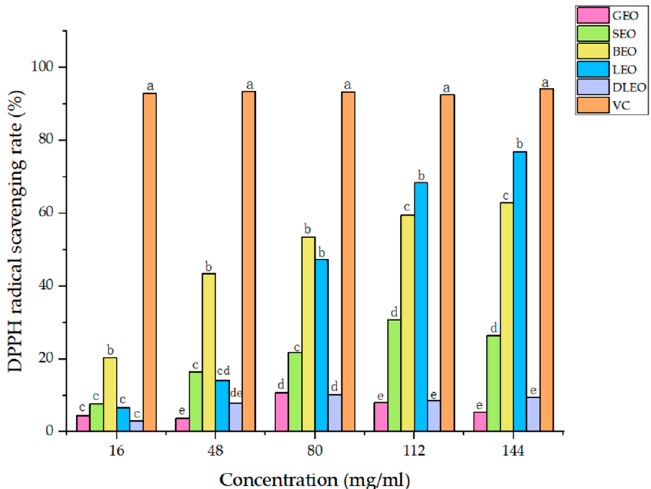
Figure 1. Effect of EO type and concentration on DPPH radical scavenging rate. Different EOs (E) and concentrations (C) had significant effects on DPPH radical scavenging rate ( P E < 0.01, P C < 0.01), and their interaction (E × C) was significant ( P E × P C < 0.01). Different letters show differences ( P <